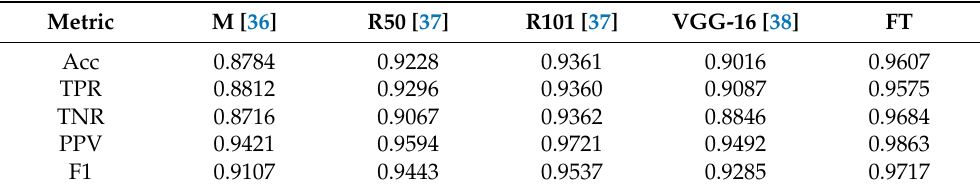
Table 7. Performance comparison on the Duke-I and Duke-II datasets. The two datasets were combined due to the overlap of the